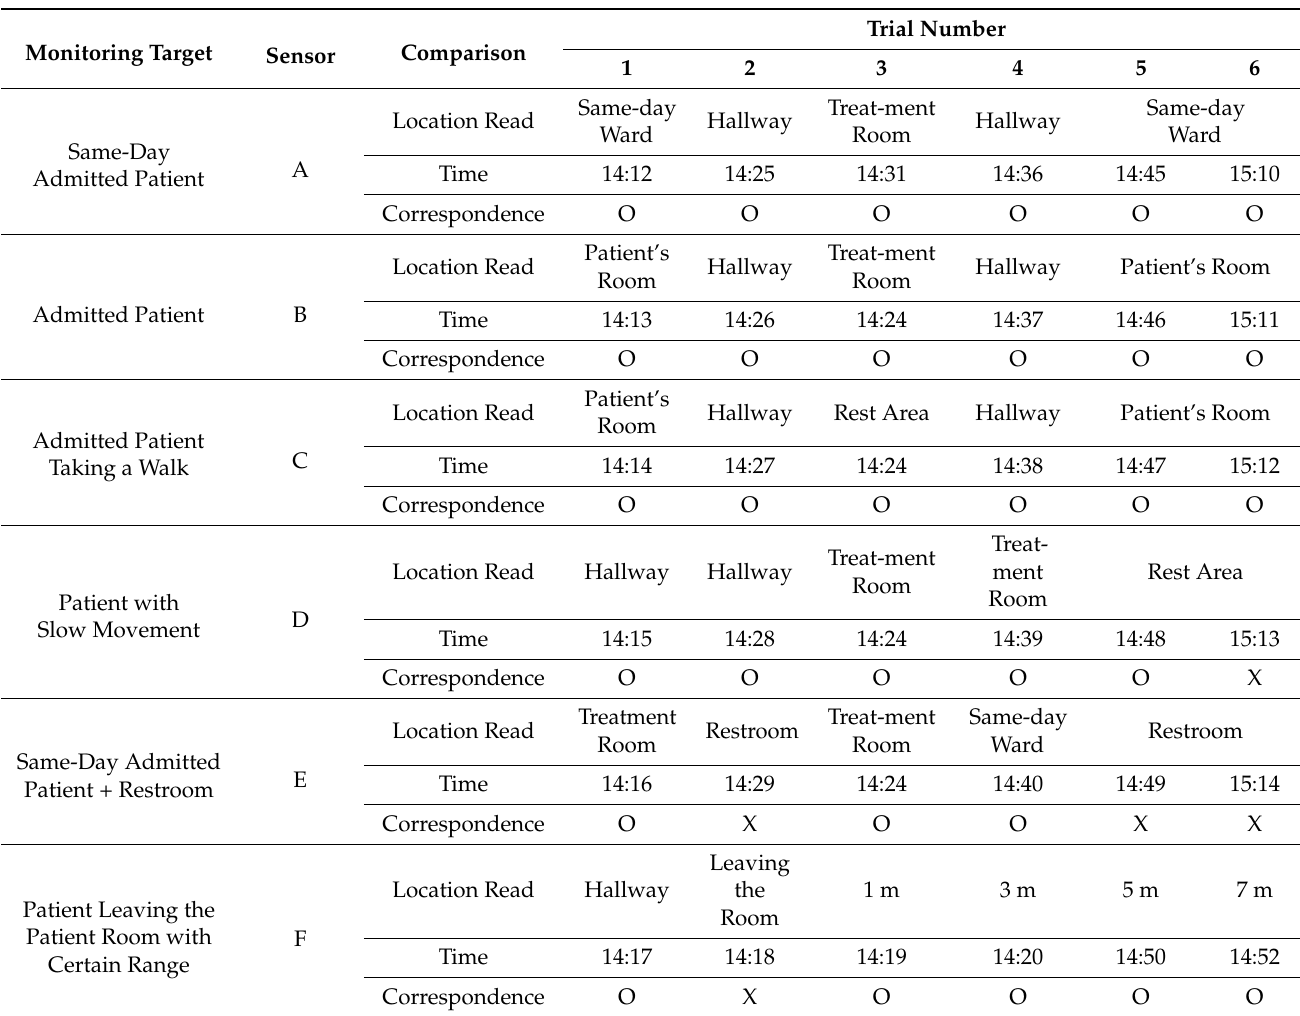
Table 8. Location of Infusion Pumps on the Patient Monitored Using the Non-Hospital Network.